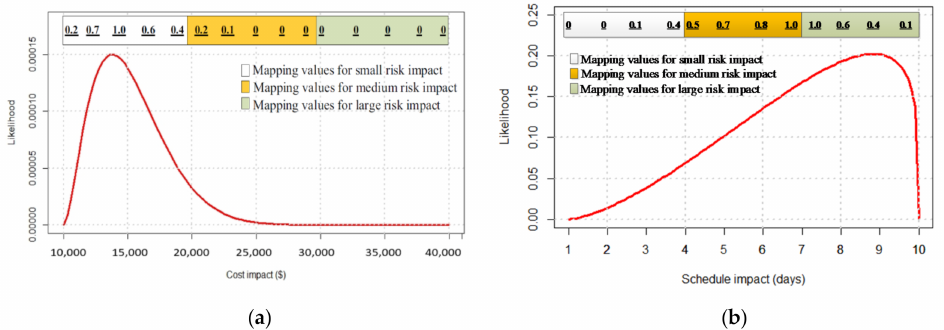
Figure 12. Final marginal distribution of the ( a ) cost impact and ( b ) schedule